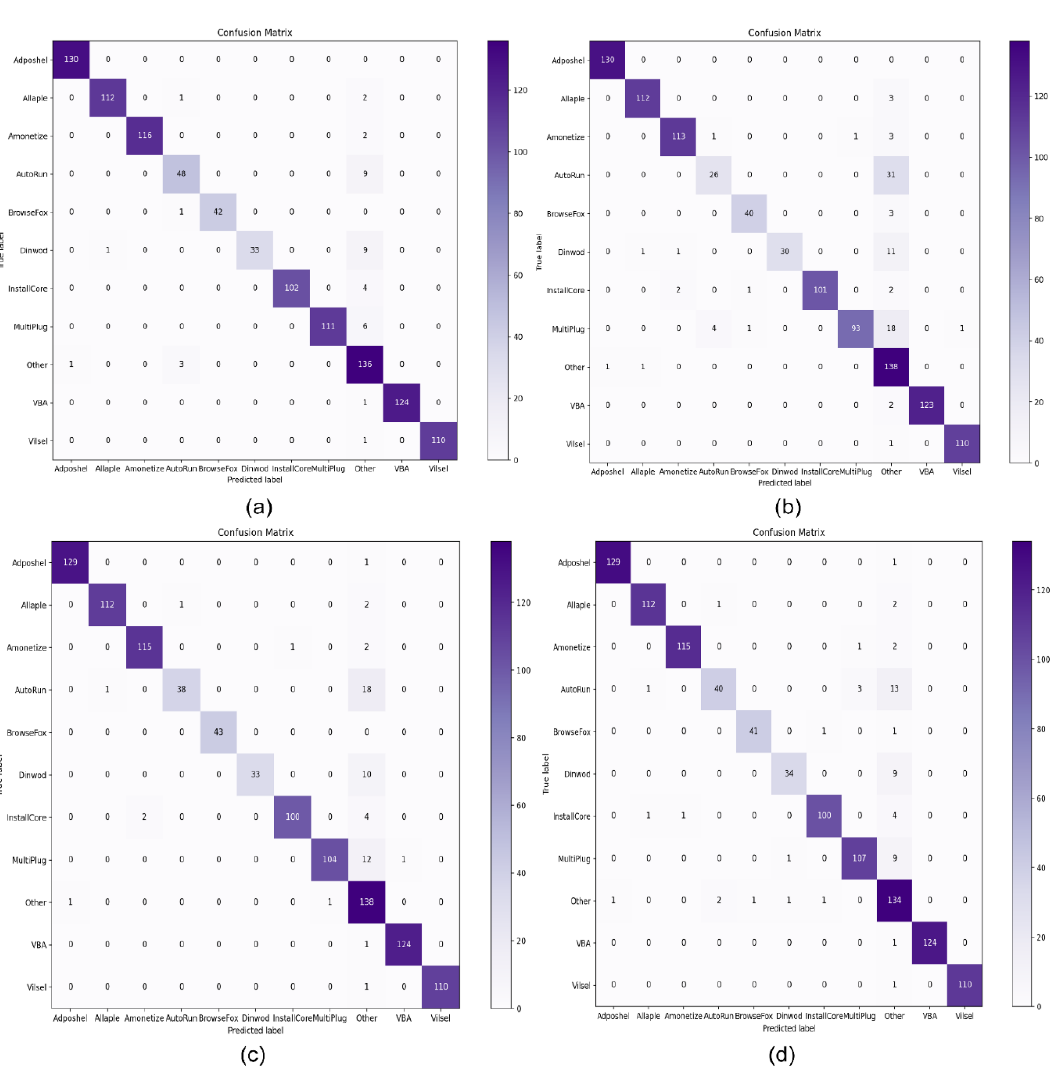
Figure 11. Confusion matrix of SVM-RBF ( a ), SVM-Linear ( b ), RF ( c ), and XGBoost ( d ) using version 1 of the dataset.